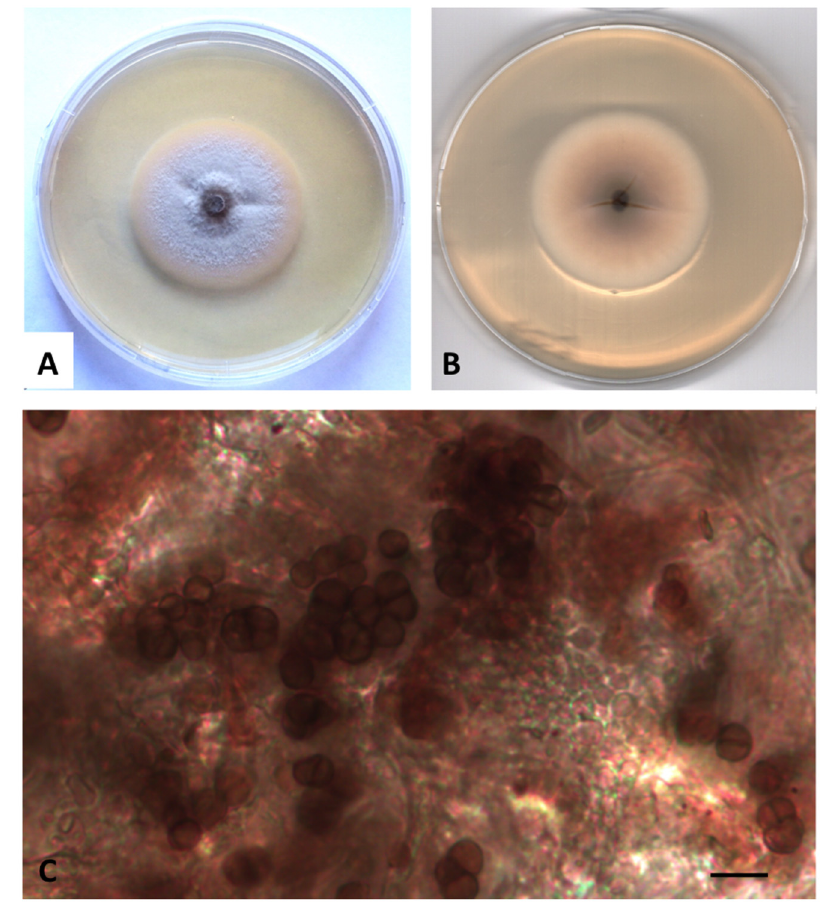
Figure 4. Parathyridaria flabelliae sp. nov. 28-days-old colony at 21 °C on MEASW ( A ) and reverse ( B ); unicellular and multicellular chlamydospores ( C ). Scale bar: 10 µm. Neoroussoella lignicola sp. nov. A. Poli, E. Bovio, V. Prigione and G.C.